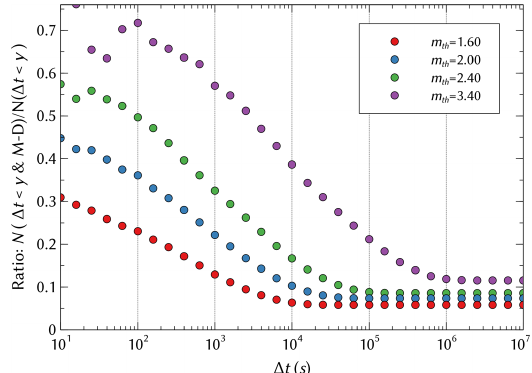
Figure 6. Ratio of total number of events satisfying (cid:49)t < y & M–D to (cid:49)t < y conditioning for the SSAR-SC catalog for different val- ues of m th